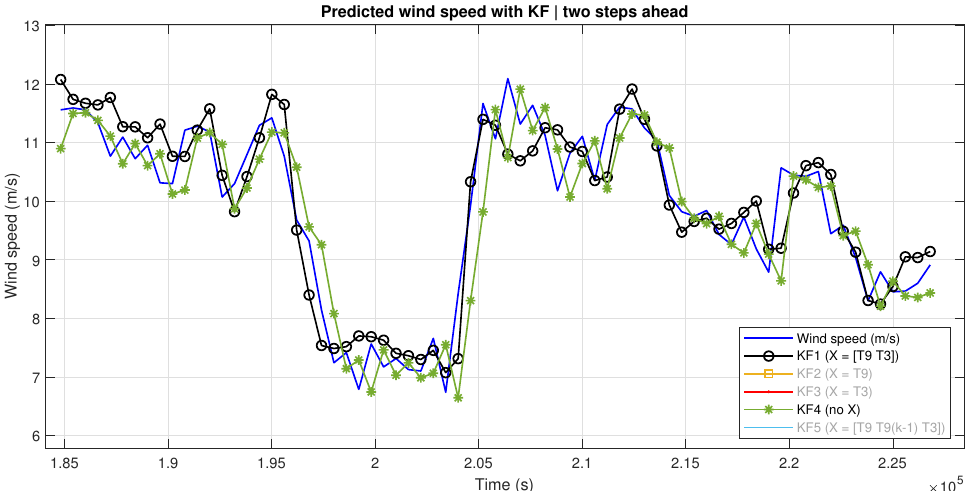
Figure 5. Example time series of the true wind speed, and the forecast wind speed, using one method with exogenous data (KF1) and the one without (KF4); see Table